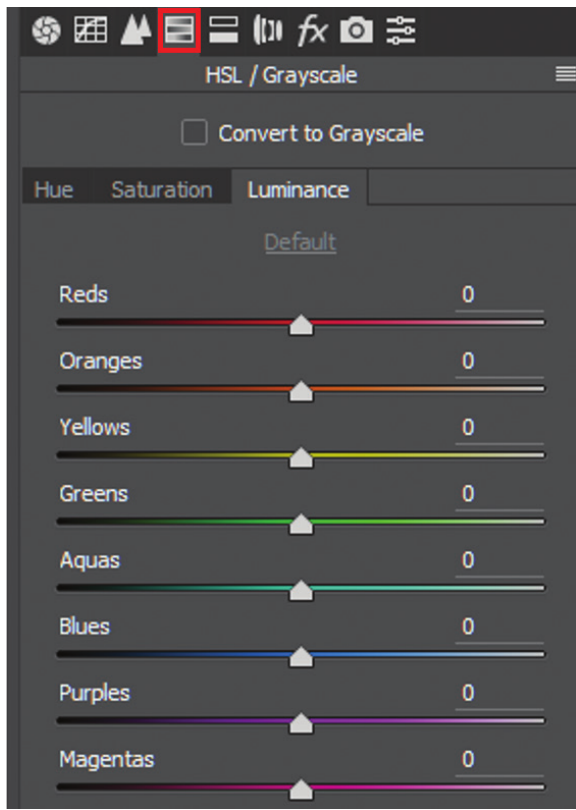
Figure 9. HSL / Grayscale panel with luminance adjustment.